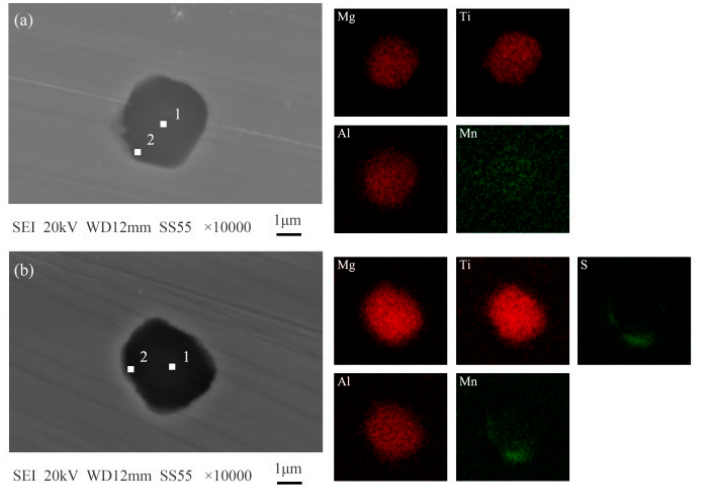
Figure 1. SEM micrographs and energy dispersive spectrometer (EDS) mapping images of various elements for typical oxides in the external adding method (EAM)-treated sample. ( a ) typical oxide 1 ( b ) typical oxide 2. Table 1. EDS point analysis of oxides for the EAM-treated sample shown in Figure 1 (mass percentage).